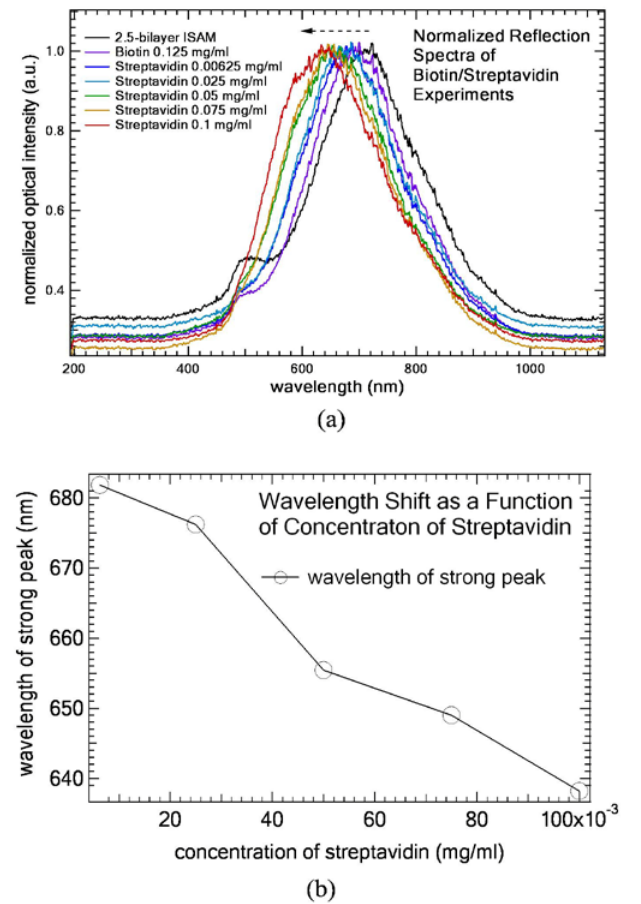
Figure 6. (a) Normalized reflection spectra measured in air as a function of the concentration of streptavidin solution using the same fiber probe. Black dash arrow indicates the direction of the wavelength shift of the longer-wavelength strong peak as concentration of streptavidin solution increases. (b) wavelength shift as a function of concentration of